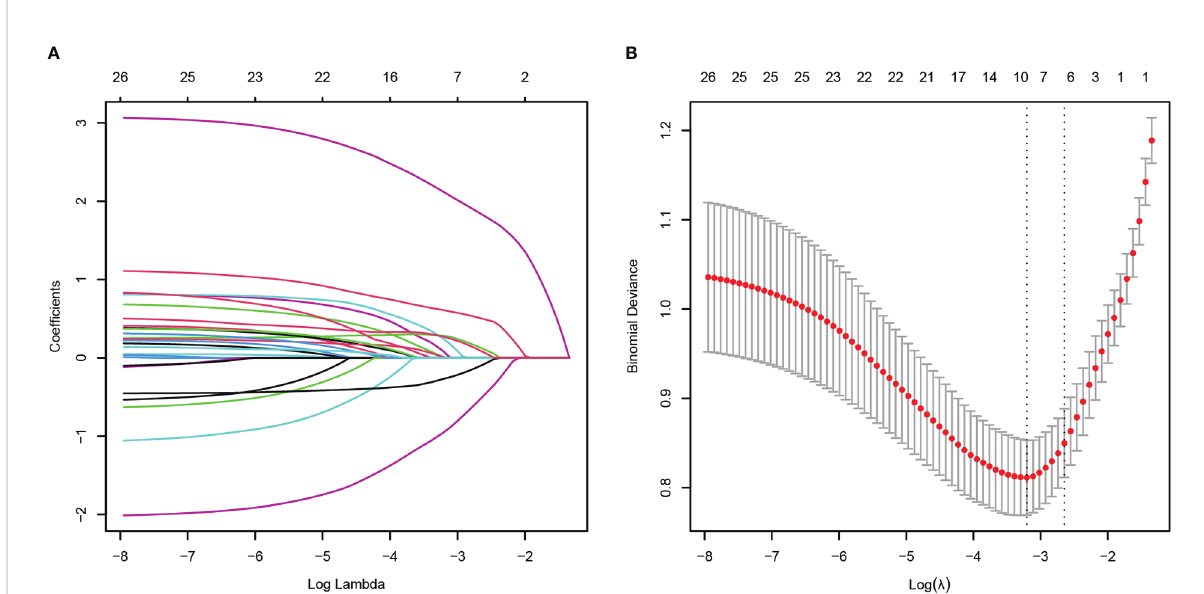
FIGURE 6 Potential risk factors selection for 28-day all-cause mortality using the least absolute shrinkage and selection operator (LASSO) regression model with 10-fold cross validation. LASSO coef fi cient pro fi les of 26 variables (A) . A coef fi cient pro fi le plot was constructed from the log (lambda) sequence (B) . The number of characteristic variables was fi ltered by drawing dotted vertical lines at lambda.min (left dotted line) and lambda.1se (right dotted line) respectively according to the minimum criterion. LASSO, least absolute shrinkage and selection operator; SE, standard